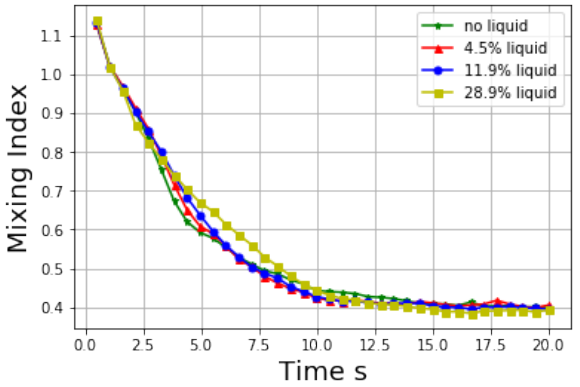
Figure 13. Mixing index at different liquid amount.